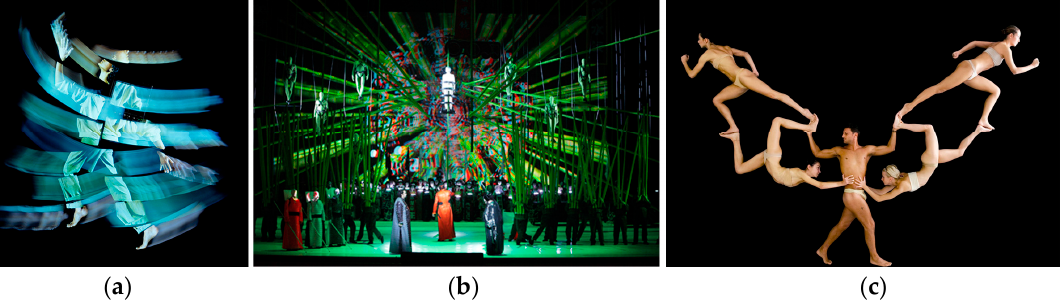
Figure 6. The scenic bozzetto is both a work of art and a technical drawing who reflects the reality, such as in this example: ( a ) Studio Azzurro (with G. Barberio Corsetti), Camera Astratta , Documenta 8, Kassel, UBU Prize 1988 for research thetre; ( b ) La Fura dels Baus, a photograph of Puccini’s Turandot , Bavarian State Opera, Munich, 2012; ( c ) Emiliano Pellisari’s Inferno , 2010–2011.